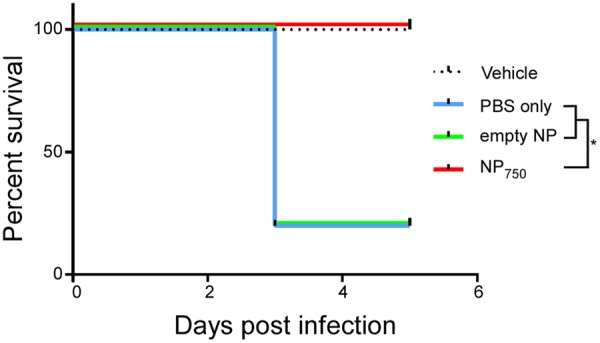
Complete protection against C. difficile challenge in vaccinated mice. Various groups of mice were treated with an antibiotic cocktail and then challenged by C. difficile or PBS. Survival was monitored for 5 days. Vehicle: health control; PBS: infection control; NP: empty nanoparticle vaccination; NP750: NP-rTcdB vaccination. All data are representative of at least three independent experiments (∗p ≤ 0.05, error bars indicate standard errors of the means; the data were analyzed by Kaplan–Meier survival analysis).